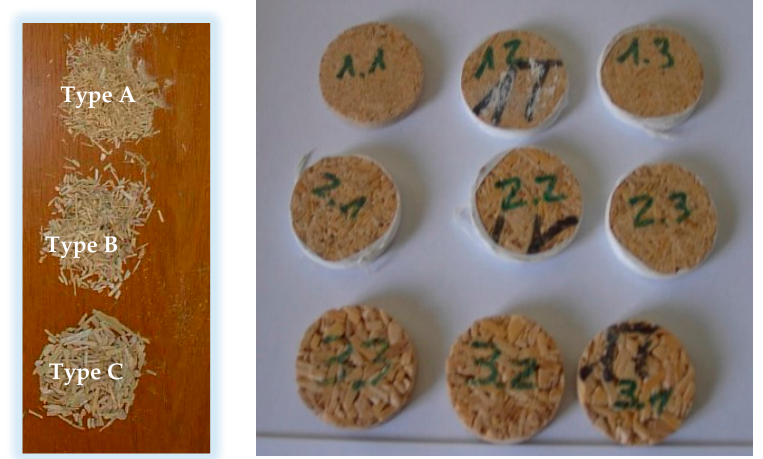
Figure 2. Particles and acoustic test samples.